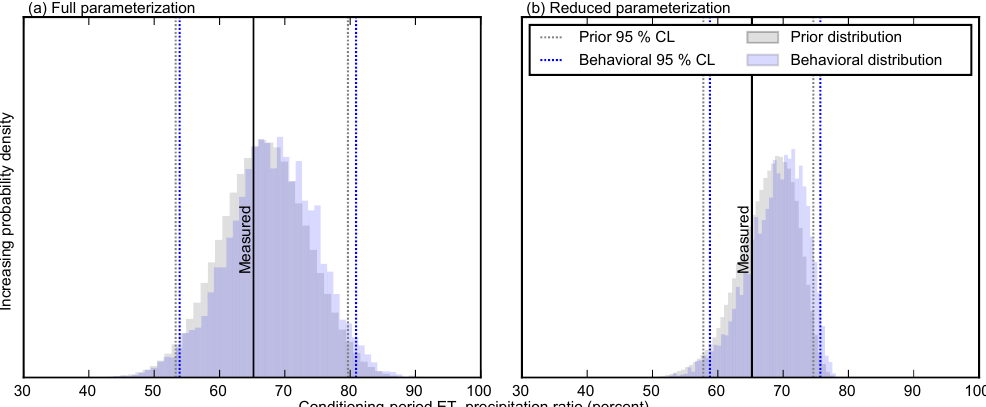
Figure 4. Quantity of interest QOI-1: simulated conditioning-period (pretreatment) ET as a percentage of precipitation. The prior and behavioral 95% confidence intervals – defined by the confidence limits (CLs) – of both model parameterizations bracket the measured value. However, the conditioning process has little affect on uncertainty as the behavioral distribution is similar to the prior distribution.